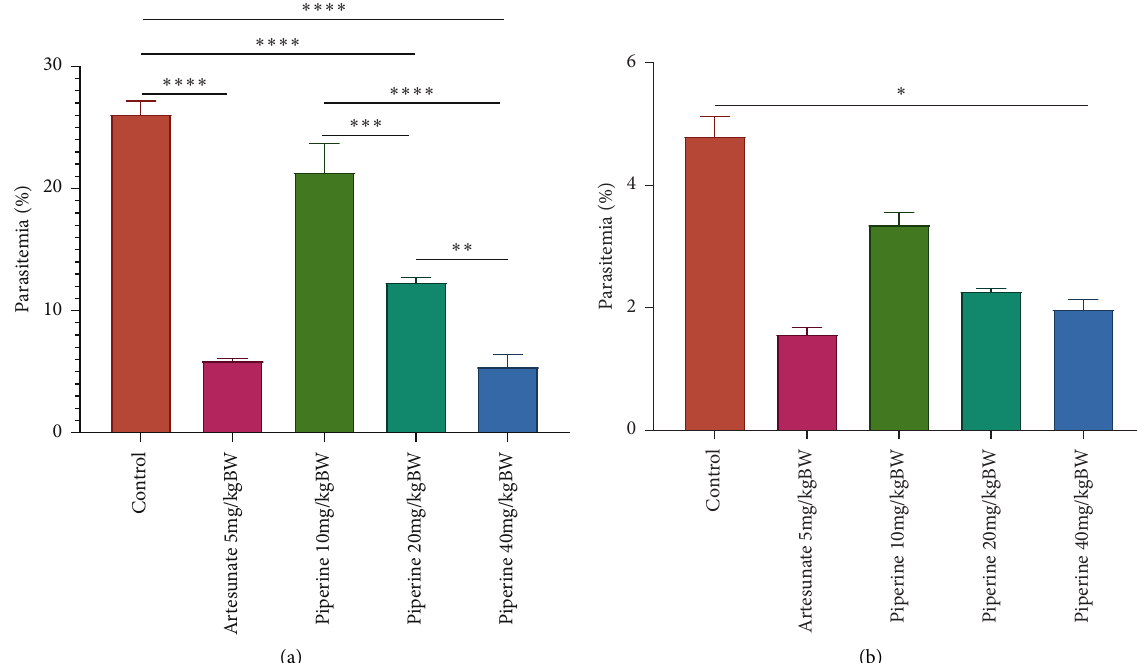
Figure 4: Degree of parasitaemia after piperine administration in mice infected with P. berghei ANKA in the (a) curative test and (b) prophylactic test ( n � 5 per group). Data are presented as mean ± SEM. ∗∗∗∗ p < 0 . 0001, ∗∗∗ p < 0 . 001, ∗∗ p < 0 . 01 compared with negative control (one-way ANOVA followed by Tukey’s post hoc test).